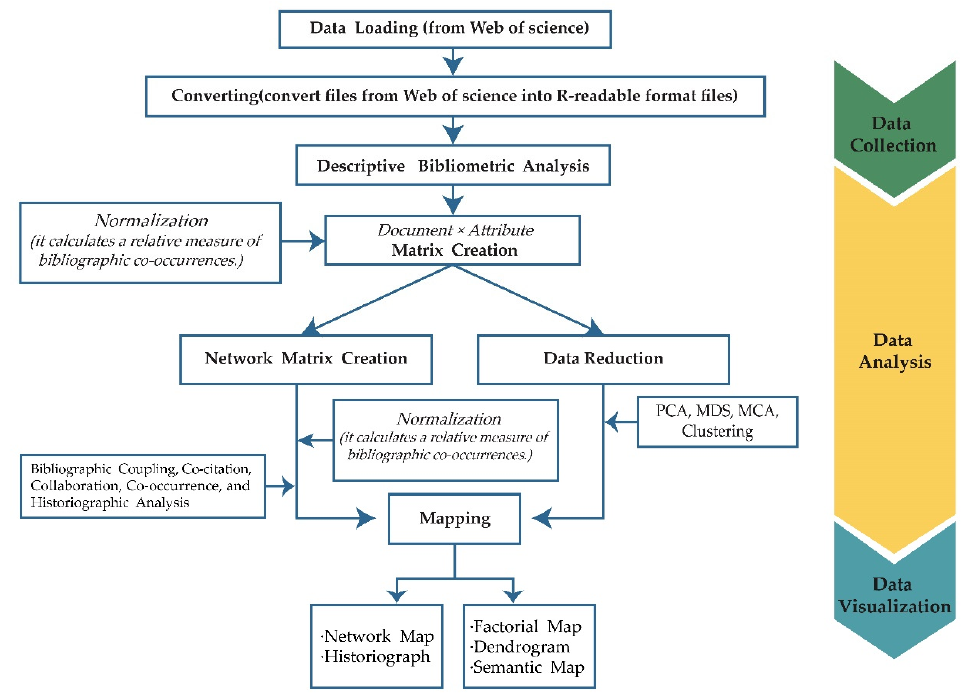
Figure 1. Bibliometrix and the recommended science mapping workflow.